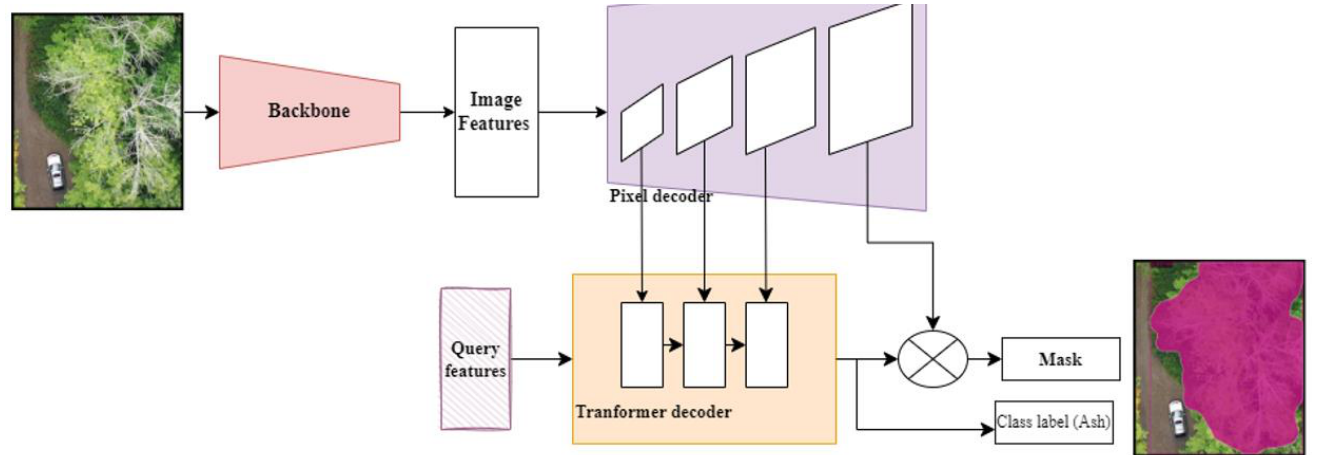
Figure 11. The overall network architecture of the deep learning model (Mask2former). The input RGB image is fed to the backbone to extract low-resolution features. The pixel decoder block upsamples the low-resolution features. The decoder block takes in the image features and queries and provides the segmentation mask and class label. The final output of the model is an RGB image with a bounding box, class label, and a segmentation mask on the predicted dead or declining ash